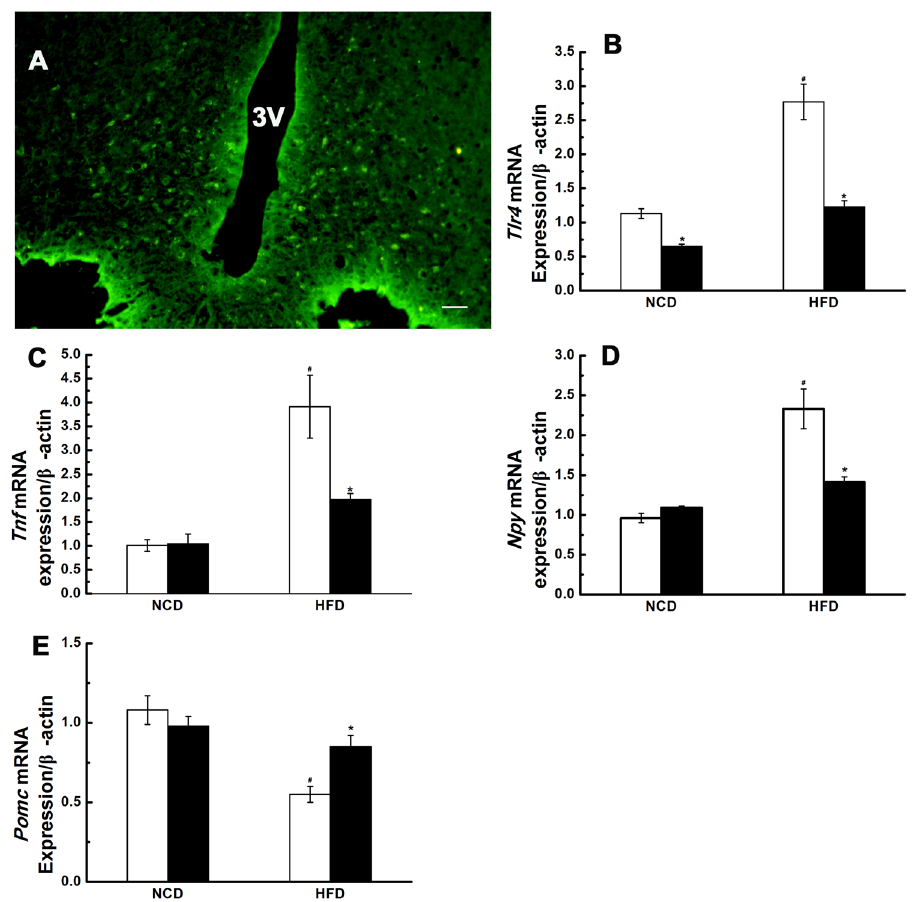
Figure 1. The mRNA expression of Tlr4 , Tnf, Npy and Pomc in the hypothalamic arcuate nucleus (ARC) at the 4th week after stereotaxical injection of Tlr4 shRNA lentiviral particles or scrambled shRNA lentiviral particles. ( A ) The copGFP Control Lentiviral Particles was used to examine the transduction efficiency in hypothalamic ARC at the 4th week after stereotaxic injection. Fluorescent microscopic image showed GFP-positive cells were still detected in the ARC after 4 weeks of injection. Scale bar, 100 μ m. The expression of Tlr4 mRNA ( B ), Tnf mRNA( C ), Npy mRNA ( D ) and Pomc mRNA ( E ) in the ARC were detected by real-time RT-PCR. The expression level of mRNA was normalized to the b-actin values. The white bar represents scrambled shRNA treated group, and the black bar represents Tlr4 shRNA treated group. NCD: normal chow diet group; HFD: high fat diet group; 3 V: the third ventricle. n = 7–8 per group. The results are shown as the mean ± S.E.M. # P < 0.05 for HFD group compared with NCD group; * P < 0.05 for Tlr4 shRNA treated group compared with scrambled shRNA treated